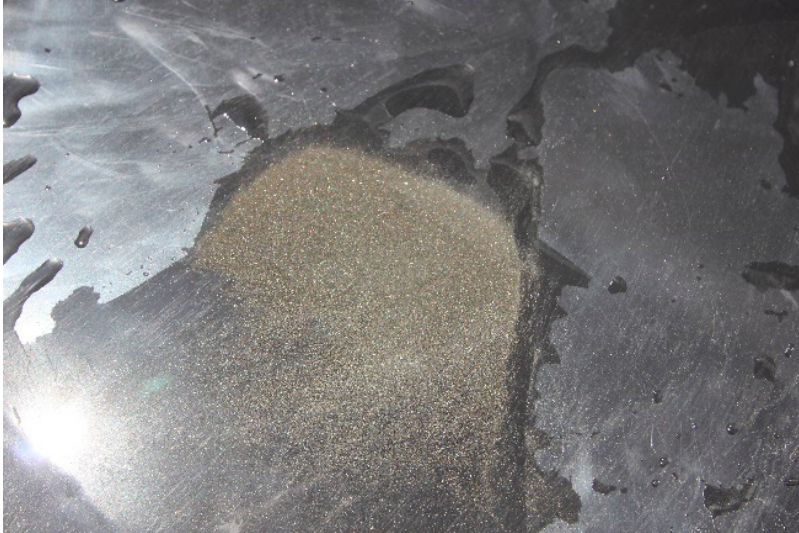
Figure 5. The final product of the ‘chair-washing’ process—in this case rich in sulphide.